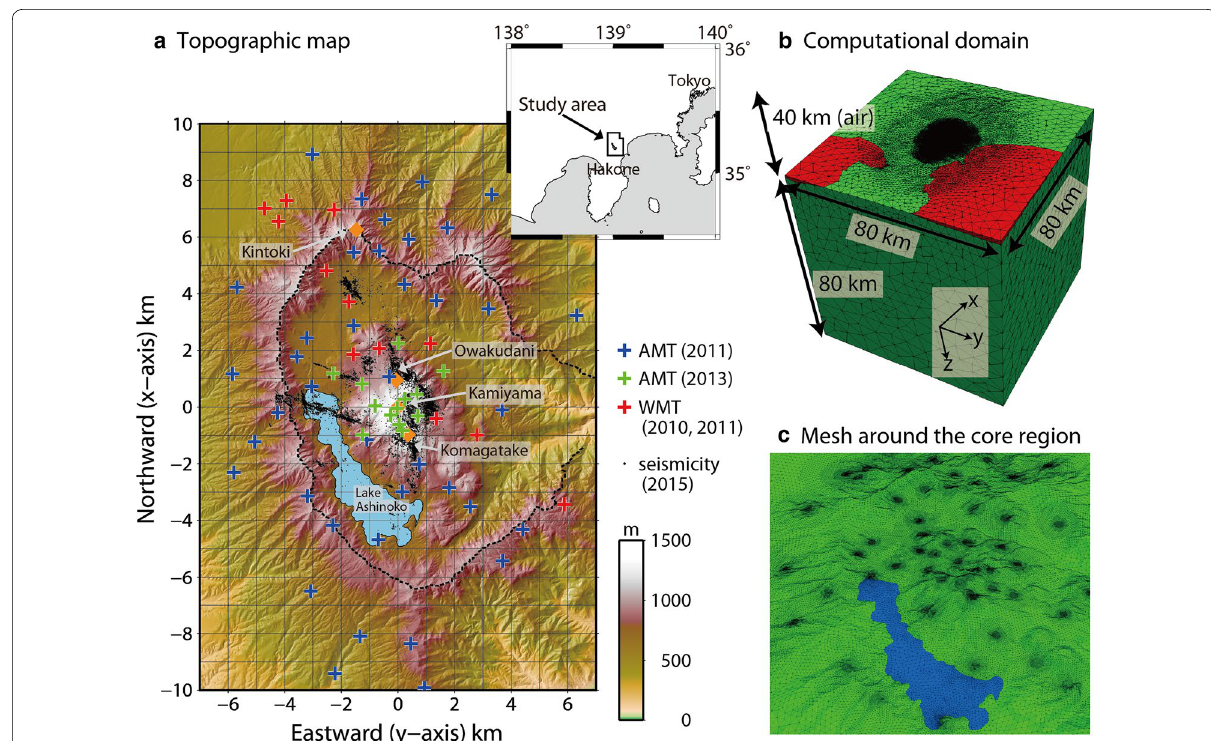
Fig. 1 Topographic map of the study area and computational mesh used in the three‑dimensional resistivity inversion. a Topographic map of Hakone volcano, Central Japan, highlighting the spatial distribution of the magnetotelluric observation sites used in this study. The blue, green and red plus symbols indicate the 2011 AMT observations, the 2013 AMT observations and the 2010 and 2011 WMT observations, respectively. The topography was extracted from a 10‑m DEM provided by the Geospatial Information Authority of Japan. The epicentres of the earthquake swarms from April to October 2015, as determined by Yukutake et al. (2017), are plotted as black dots. The black dotted line indicates the caldera rim of Hakone volcano. The orange diamonds mark the Owakudani geothermal area, central cones (Mts. Kamiyama and Komagatake) and Mt. Kintoki. The surface extent of Lake Ashinoko is shown in blue. b Subsurface computational domain without air elements. The origin of the mesh was set at the sea level just beneath Mt. Kamiyama. The tetrahedral lattice in the central portion of the computational domain, covering the core region of Hakone volcano and encompassing all the MT/AMT sites, was made at a finer resolution. The green, red and blue colours indicate the elements located in land, seawater and lake water, respectively. c Surface mesh around the core region. The tetrahedral lattice was subdivided into an even finer mesh around the AMT/WMT